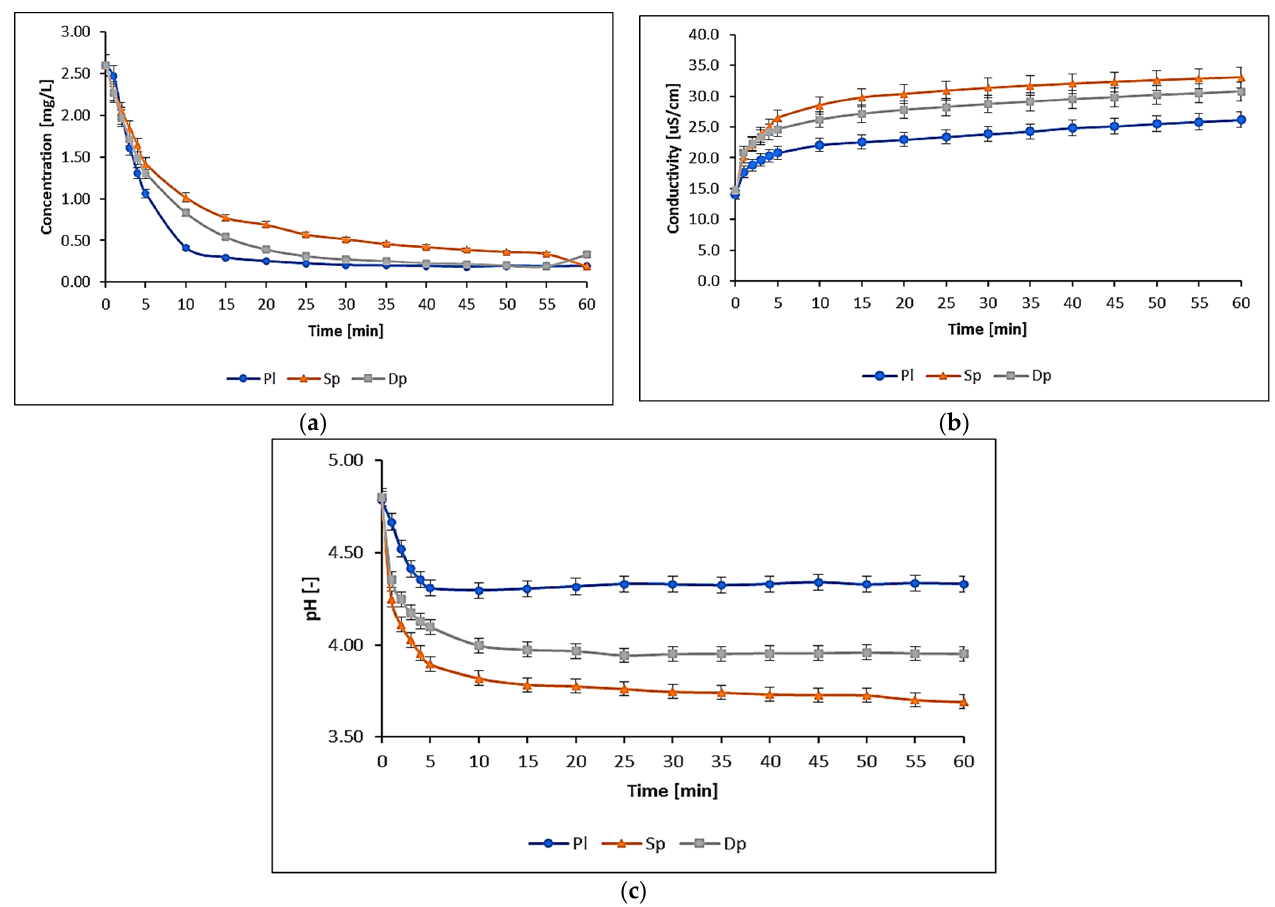
Figure 1. Changes in physicochemical parameters in Cu solution during the accumulation process of moss gametophytes: ( a ) concentration; ( b ) conductivity; ( c ) pH (Pl— P. schreberi , Sp— S. fallax , Dp— D. polysetum ). Whiskers indicate standard deviation levels.